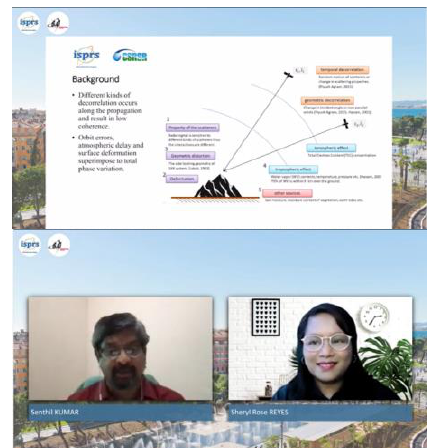
Figure 2. The presentation by Yen Yi Wu of the National Central University and the session chairs, Dr. Senthil Kumar, President of Technical Commission V and Sheryl Rose Reyes, President of the ISPRS